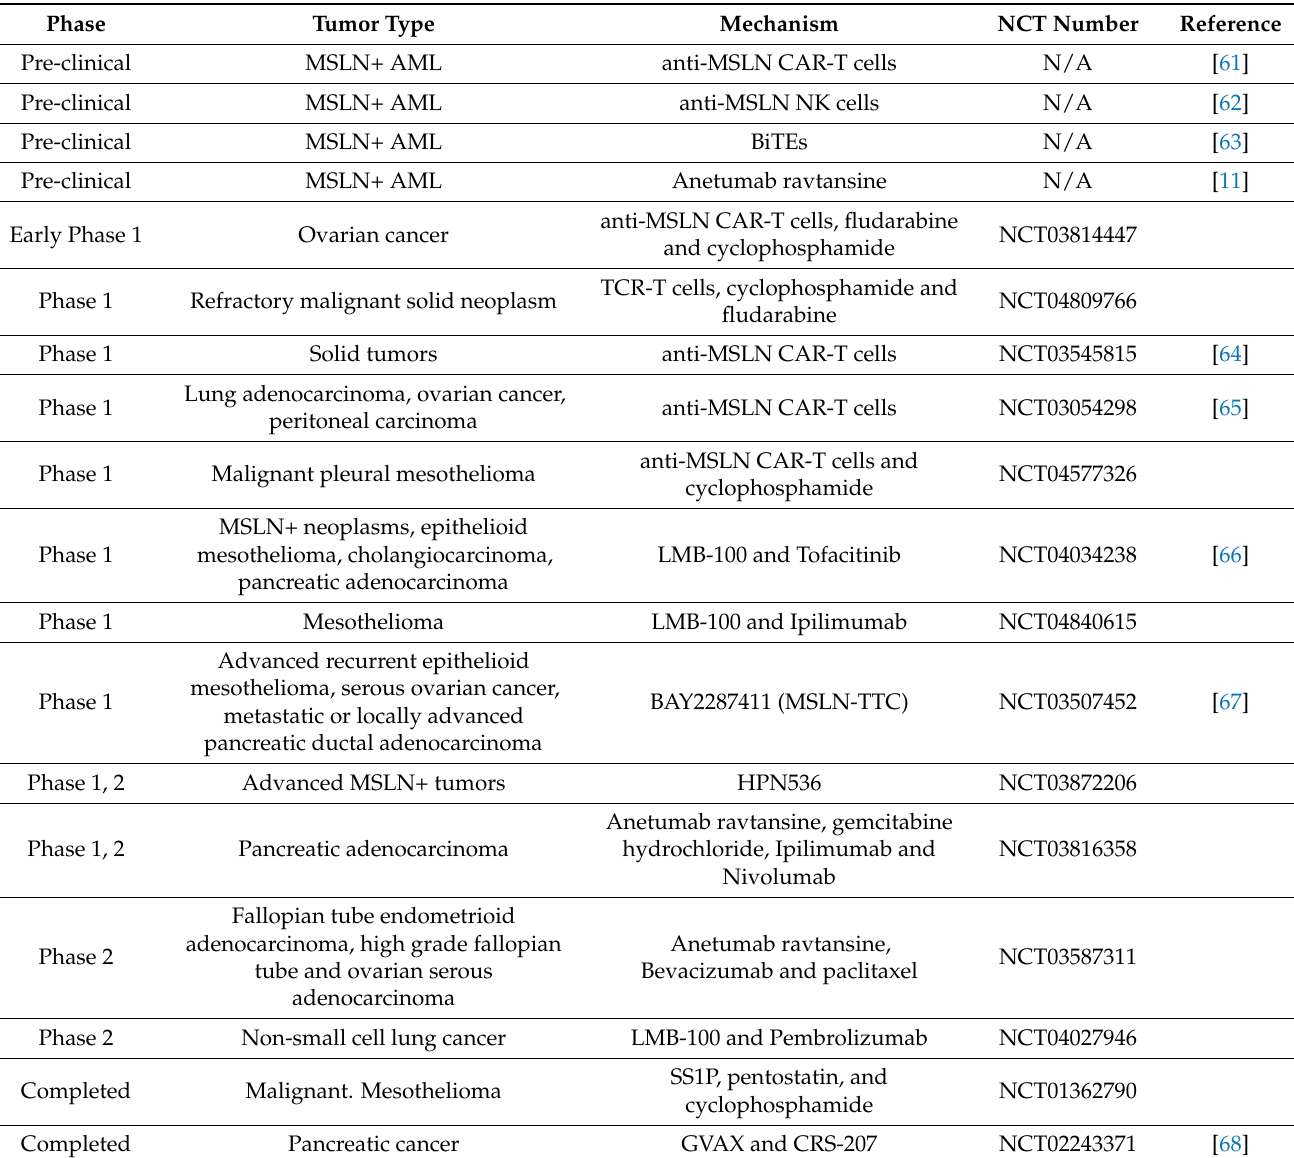
Table 1. Current pre-clinical and clinical studies targeting mesothelin (MSLN) in solid tumors and hematological